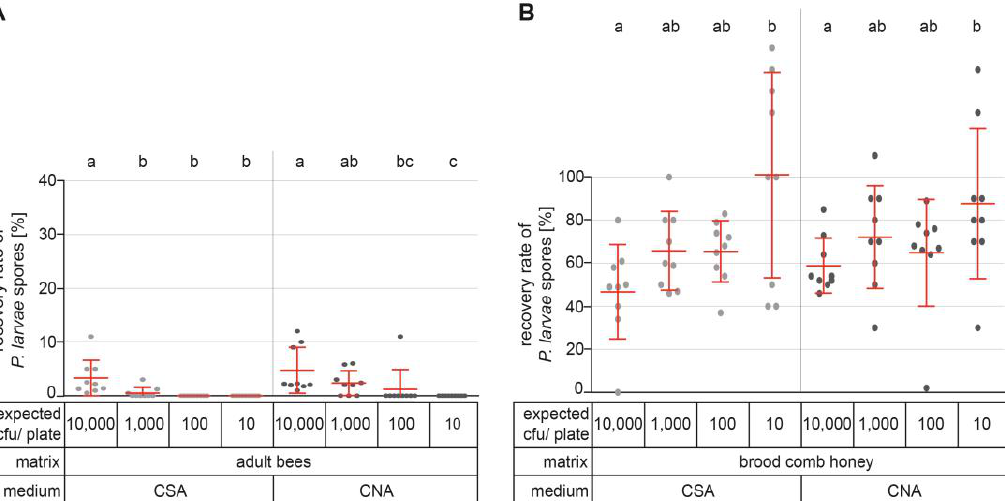
Figure 4. Determination of the recovery rate (%) of P. larvae spores in adult bee and brood comb honey samples. ( A ) Adult bee samples and ( B ) brood comb honey samples were spiked with different numbers of P. larvae spores, which could have resulted in 10,000 cfu/plate, 1000 cfu/plate, 100 cfu/plate, and 10 cfu/plate. Scatter plots show nine samples each per matrix, culture medium, and expected cfu/plate. Groups with different letters differ significantly, while groups with the same letter are not significantly different (Kruskal–Wallis nonparametric testing with Dunn’s multiple comparison test, with a significance level of p < 0.05). In addition, mean values ± SDs of the nine independent samples are given.